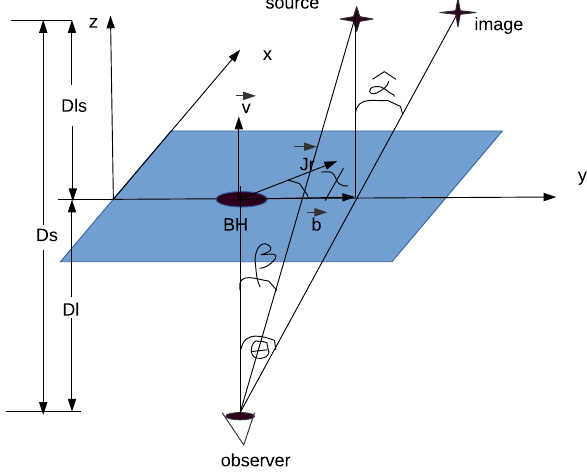
Fig. 2 Schematic representation of the gravitational lensing system. Here, χ represents the inclination angle between the vectors J r and b . In the figure D s , D l , and D ls are the distances from the source to the observer, from the lens to the observer, and from the source to the lens, respectively